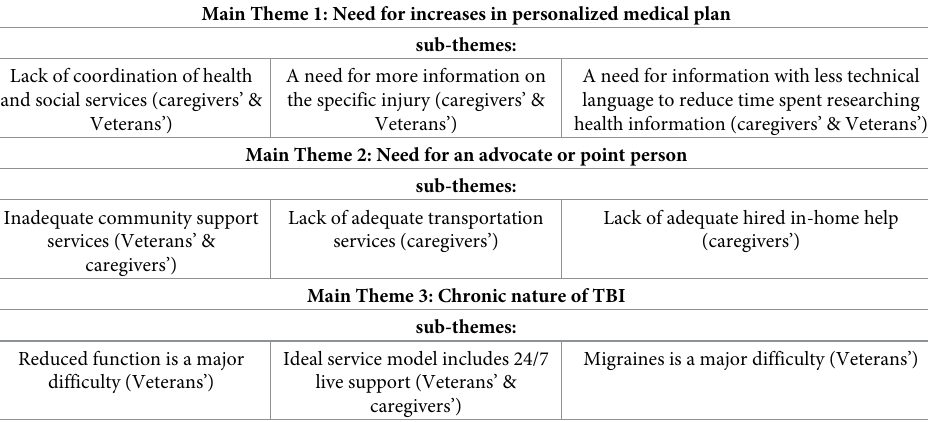
Table 4. Themes and sub-themes from qualitative